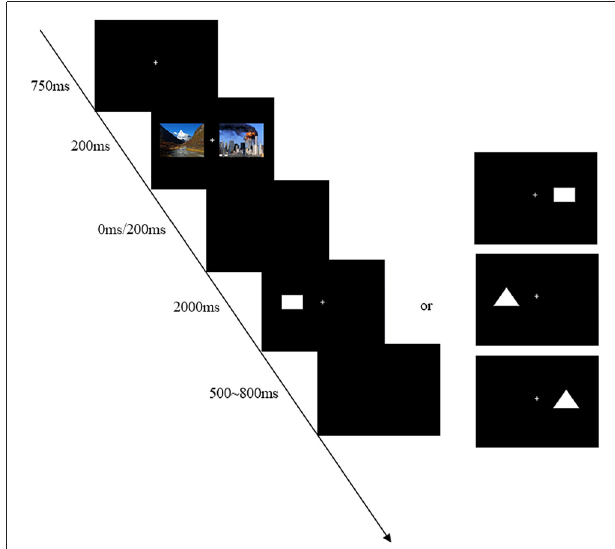
FIGURE 1 | An example of timing and sequence of stimuli. First, the stimuli-presenting mode of bilateral vision was adopted in this experiment in order to avoid the automatic attraction of attention for the unilateral vision. Second, two kinds of pictures (emergency pictures and landscape pictures) would be presented at the same time so as to avoid the sequence effect. For instance, one landscape picture was presented on the left side and one emergency picture was presented on the right side in Figure 1. The trials with different locations were embedded within each block. Finally, the experiment was divided into two kinds of pressing buttons to be counter-balanced across participants, including “F–J” and “J–F” response patterns.